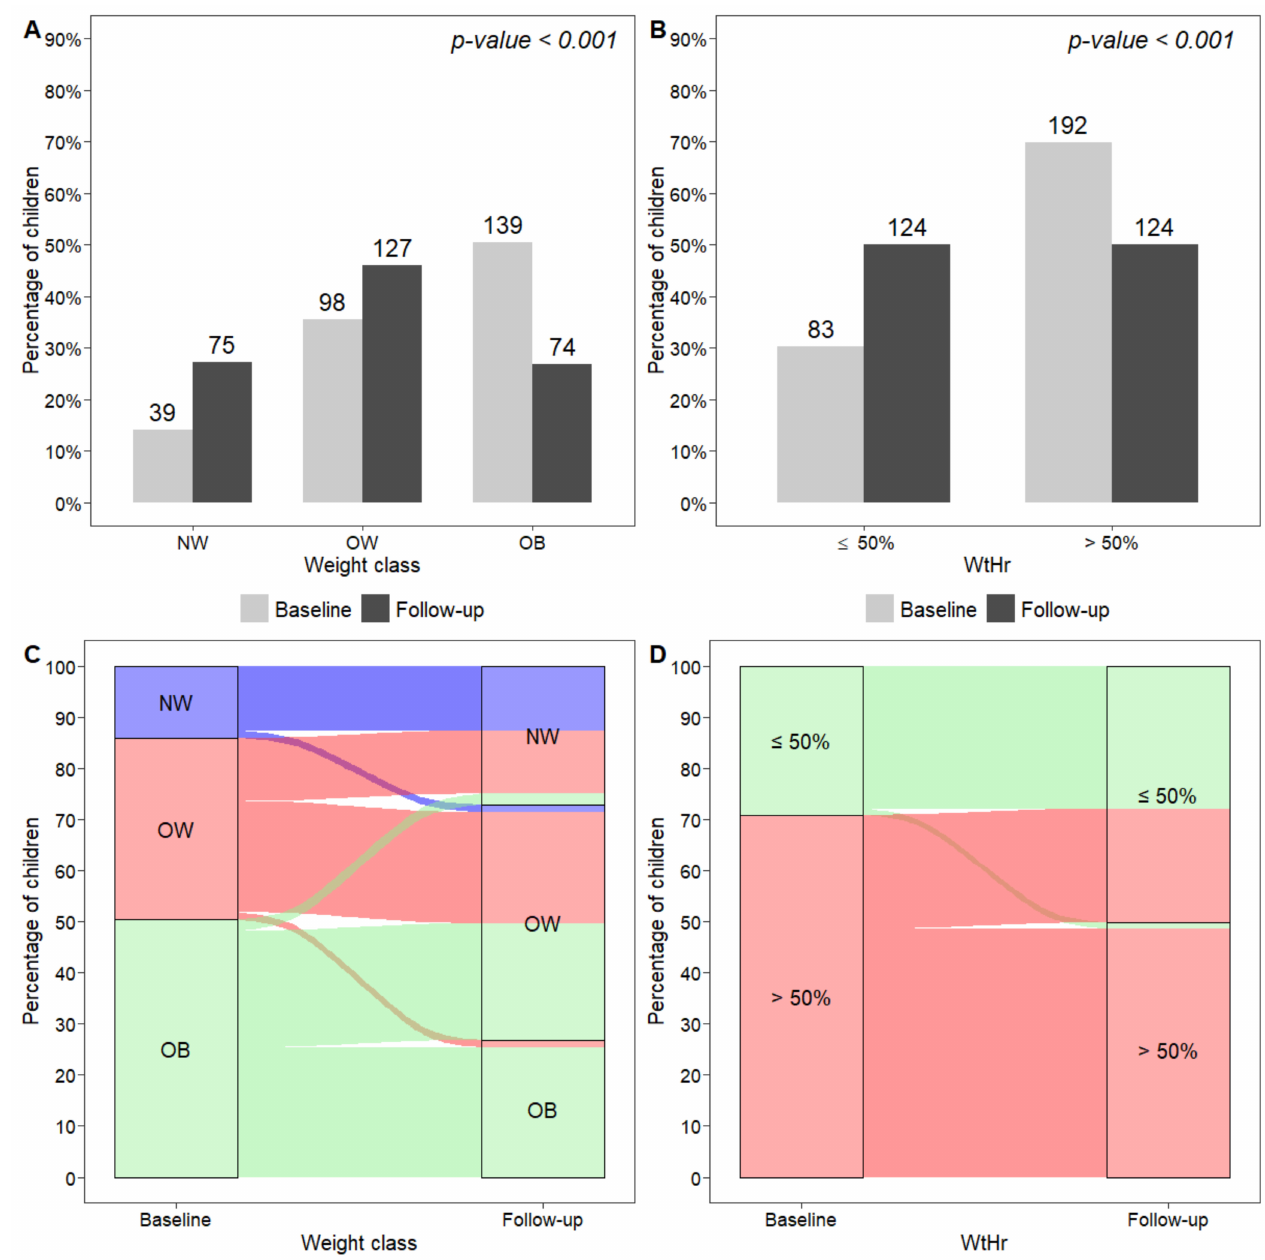
Figure 1. Distribution of weight classes ( A ) and WtHr ≤ 50% or >50% ( B ) at baseline and at follow-up, and graphical representation of subjects moving from one weight class to another ( C ), and from a WtHr value > 50% to a value ≤ 50% and vice versa ( D ), from baseline to follow-up. NW, normal weight; OW, overweight; OB, obese; WtHr,